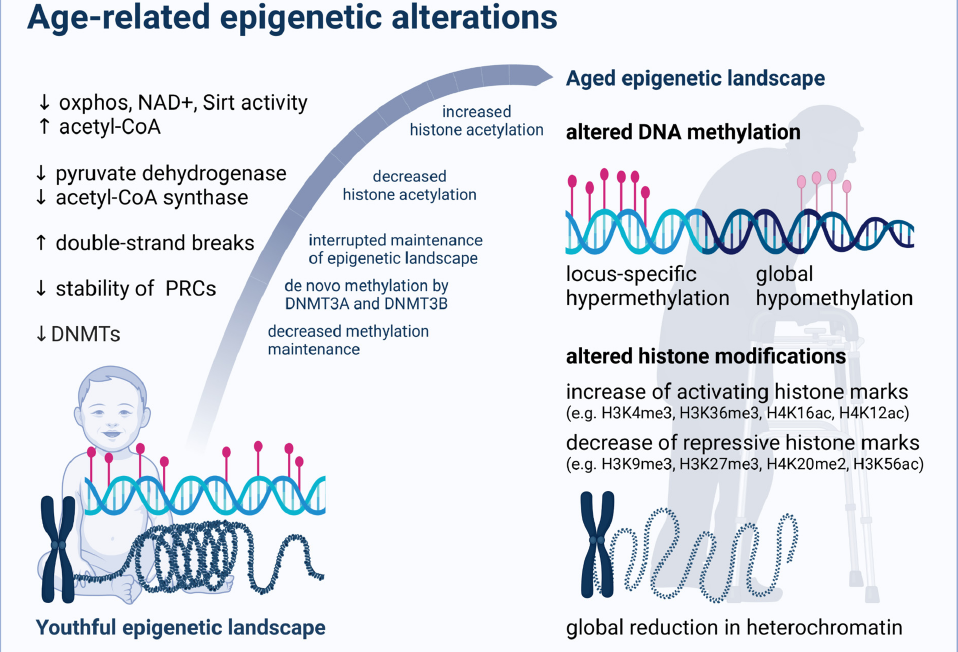
Figure 2. Age-related alterations and potential underlying mechanisms. Aging induces a number of metabolic and functional changes that result in a modified activity of epigenetic enzymes, eventually causing the altered epigenetic landscape of aged organisms exemplified here. However, it is not possible to deduce a general road map for epigenetic aging, as individual alterations can be specific for species, genders, tissues and cell types. Moreover, the complex interplay of the diverse regulation mechanisms is still poorly understood and likely changes at various stages throughout